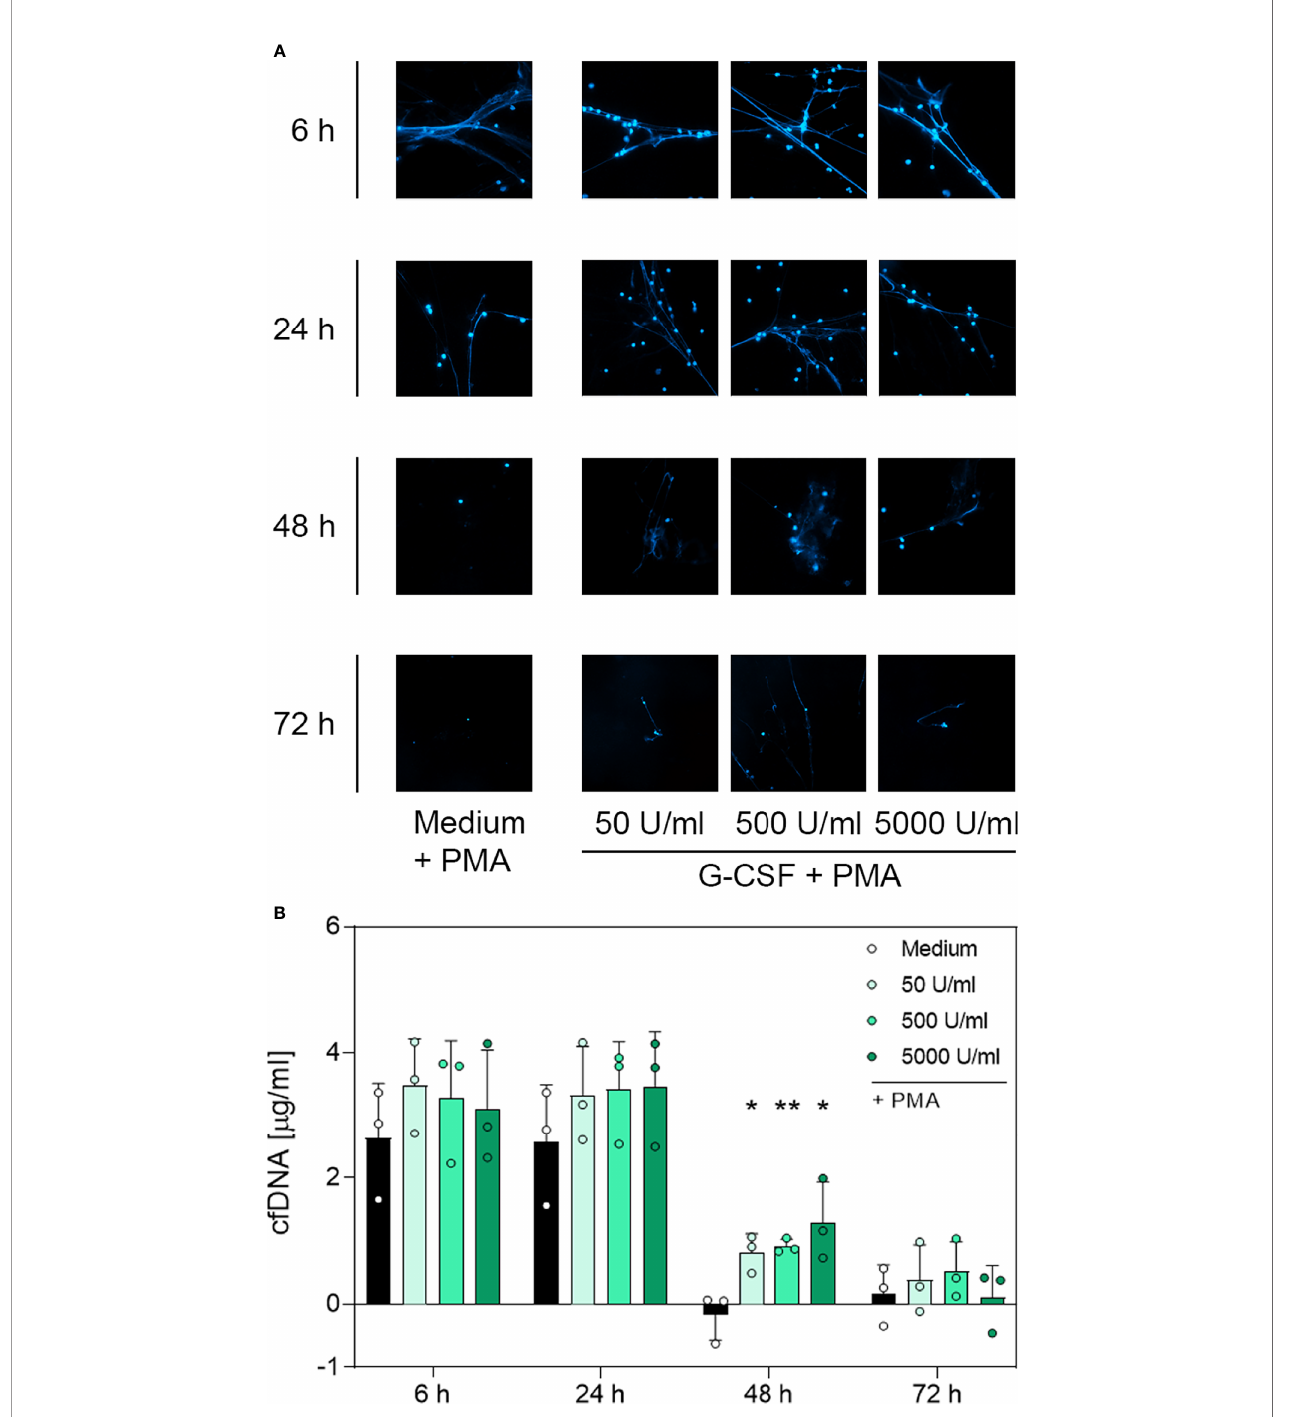
FIGURE 4 | Immuno fl uorescence imaging of extracellular DNA and quantitative analysis of cfDNA induced by PMA after incubation with G-CSF. (A) Immuno fl uorescence imaging shows extracellular DNA of neutrophils cultured with 50 U/mL, 500 U/mL, 5000 U/mL of G-CSF or of an untreated control (medium). Cells were stimulated with 20 nM PMA at the indicated time points. After fi xation, DNA was stained with 1 µg/mL DAPI (blue). PMA-induced NET formations can be detected after up to 48 h after treatment with G-CSF. Images represent areas with comparable cell density at 40× magni fi cation. (B) Quanti fi cation of PMA-induced cfDNA release by fl uorometric measurement of cfDNA after treatment of neutrophil granulocytes with 50 U/mL, 500 U/mL or 5000 U/mL of G-CSF compared to untreated control (medium). Fluorometric measurement was performed with samples stimulated with 20 nM PMA after 6 h, 24 h, 48 h and 72 h. G-CSF preserves cfDNA release for up to 48 h with signi fi cant difference compared to the untreated group. Values represent means ± SD of n = 3. Differences between the untreated control group and one treated group each were calculated individually using student ’ s t-test. Levels of signi fi cance were set at < 0.05 (*), < 0.01